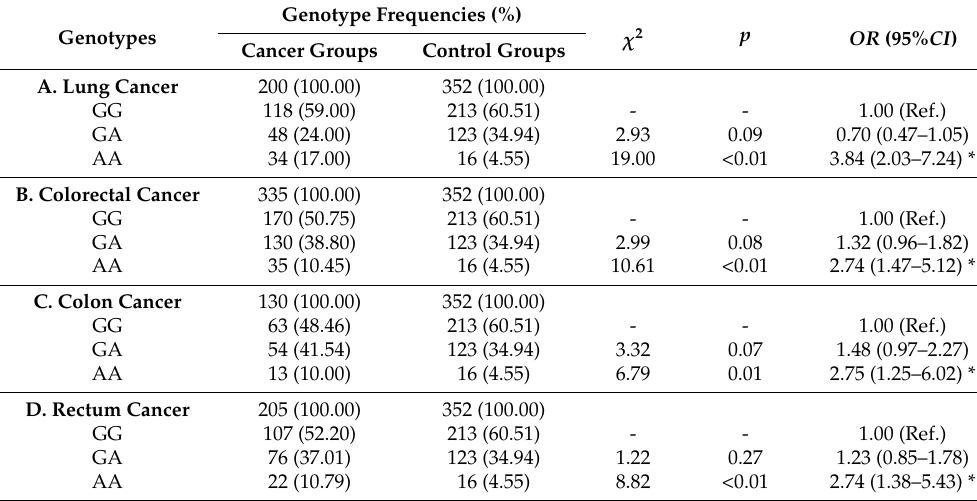
Table 4. LOX G473A genotype frequency distribution in tested population.